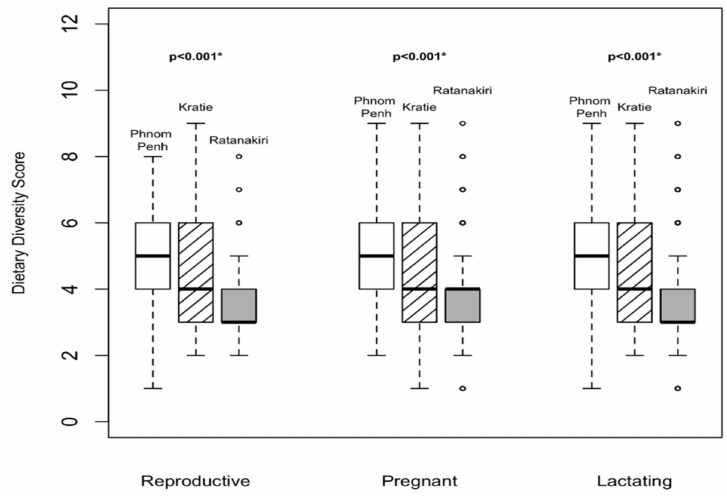
Figure 1. Comparison of women’s dietary diversity scores between regions and physiological status. *: Kruskal-Wallis test performed; ◦ : out